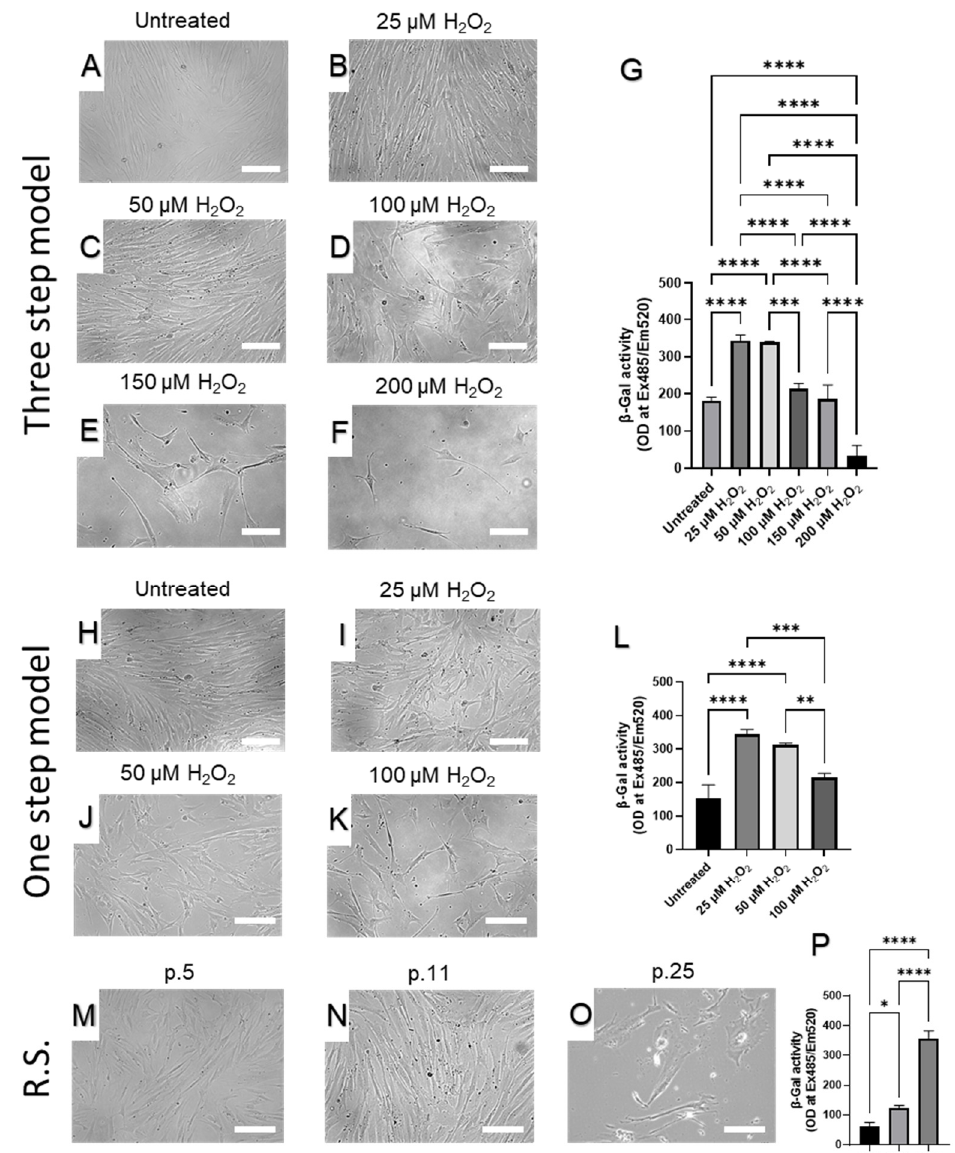
Figure 3. Human skin fibroblasts (CCD-1064Sk) p.13 exposed to H 2 O 2 (Step 3 of the three-step senescence model). ( A – F ) The images represent gradual changes in cell quantity and quality after 15 days (three-step model) of exposure to different concentrations of H 2 O 2 : ( A ) Untreated; ( B ) 25 µ M; ( C ) 50 µ M; ( D ) 100 µ M; E, 150 µ M; F, 200 µ M; ( G ) Levels of β -Gal activity after H 2 O 2 exposure on day five, step 3 (three-step model), were compared with untreated cells (CCD-1064, p.13). ( H – K ), the images represent gradual changes in cell quantity and quality after five days (one-step model) of exposure to different concentrations of H 2 O 2 : ( H ) untreated; ( I ) 25 μ M; ( J ) 50 μ M; ( K ) 100 μ M; ( L ) Levels of β -Gal activity after H 2 O 2 exposure on day five (one-step model of senescence). ( M – O ), The images represent gradual changes in cell quantity and quality in different passages (p.5, p.11, and p.25 respectively) of CCD-1064Sk skin fibroblasts during replicative senescence (RS) development; ( P ) Levels of β -Gal activity in different passages of dermal fibroblasts (CCD-1064Sk). Data were analyzed with a one-way ANOVA test (Tukey post-hoc multiple comparison test). Significance is indicated within the figures using the following scale: *, p < 0.05; **, p < 0.01; ***, p < 0.001; ****, p < 0.0001. Bars represent mean ± SD. Scale bars = 100 μ m.